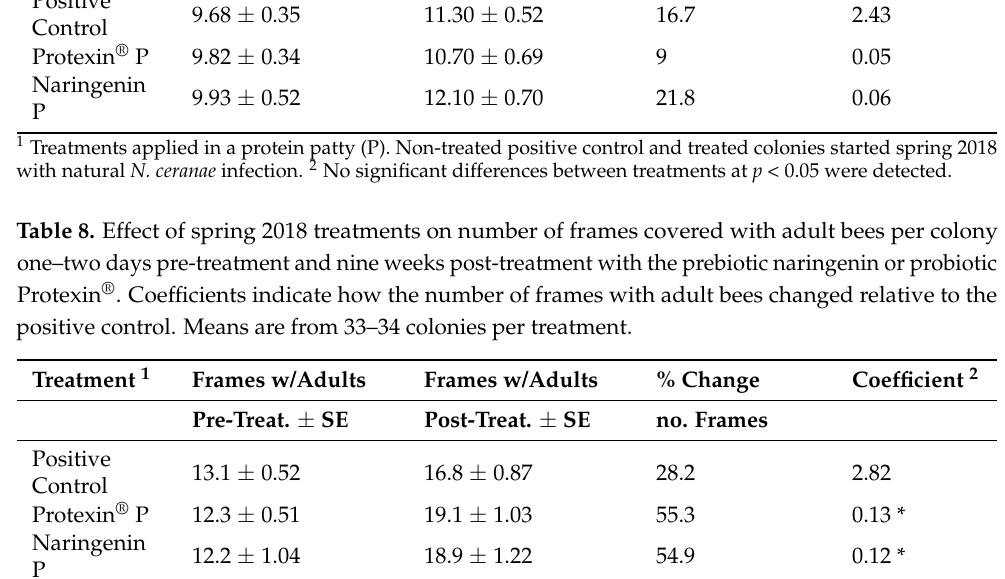
1 Treatments applied in a protein patty (P). Non-treated positive control and treated colonies started spring 2018 with natural N. ceranae infection. 2 Significance at p < 0.05 is indicated by